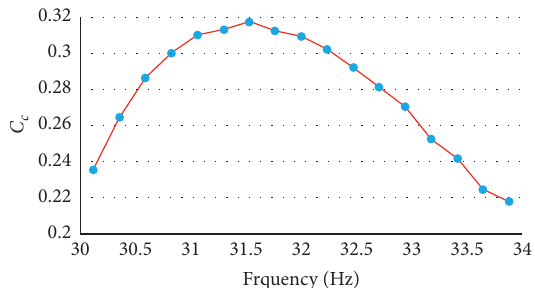
Figure 17: Recognized coupling damping coefficient.